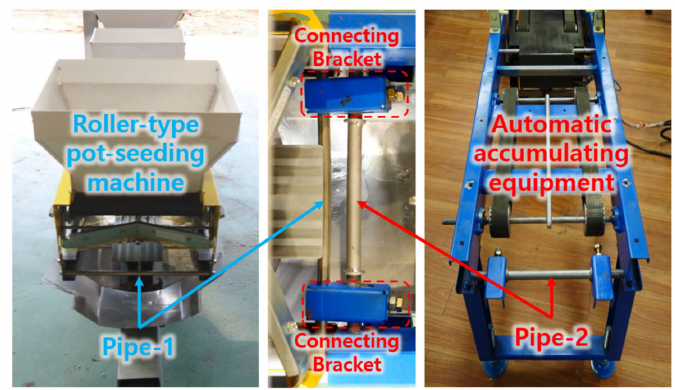
Figure 11. View of connecting